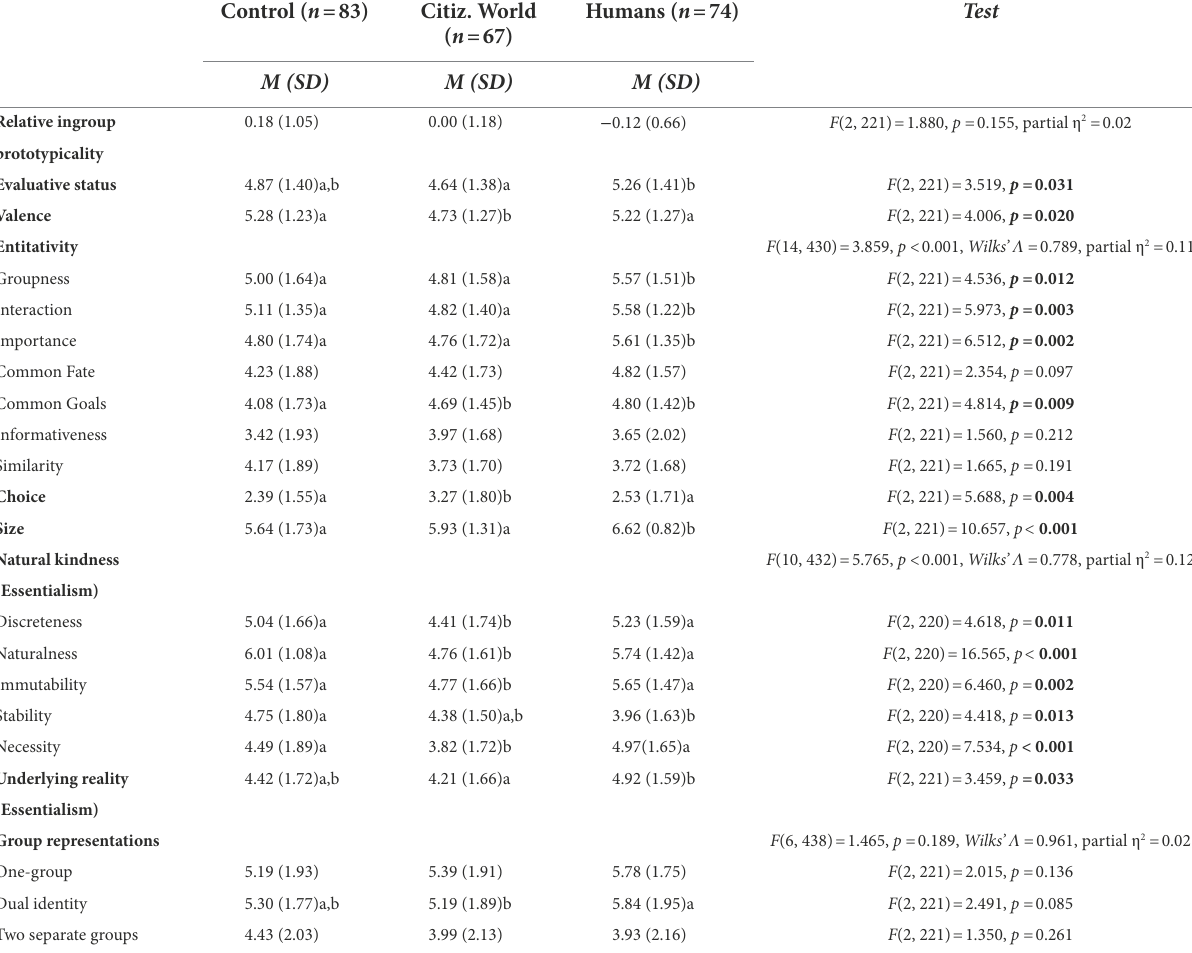
TABLE 5 Means, SD s and differences regarding the representation of the categories “citizens of the world” and